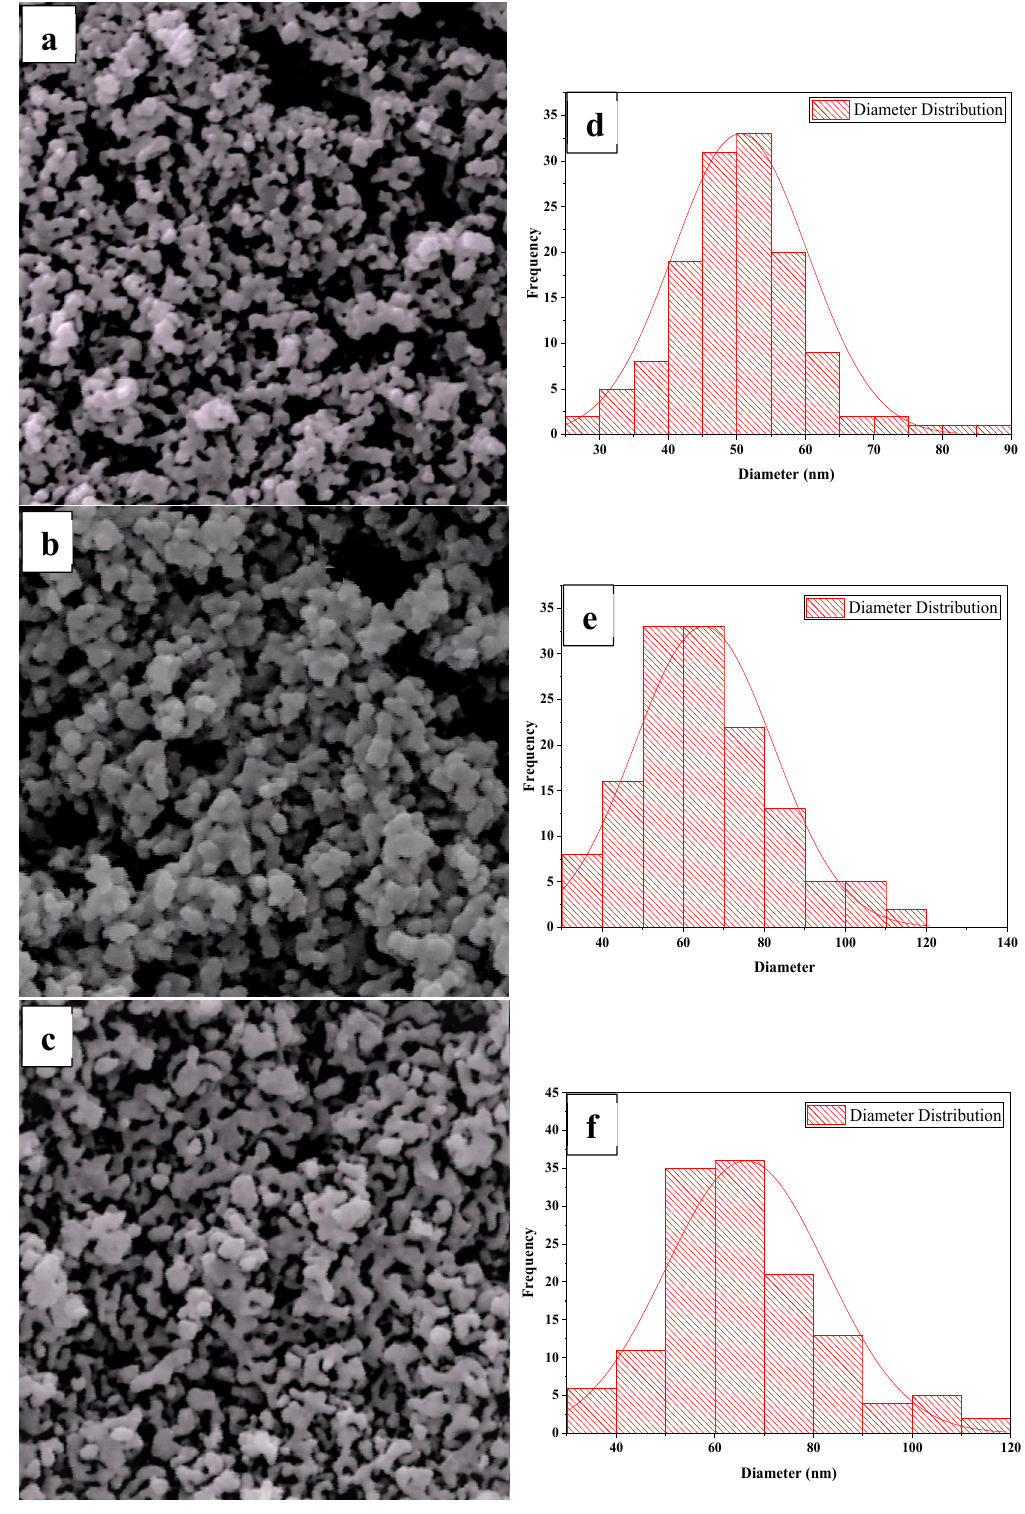
Figure 3. SEM images of Fe 3 O 4 / AC / TiO 2 : ( a ) 1:1, ( b ) 1:2, ( c ) 1:4, and ( d – f ) corresponding particle size